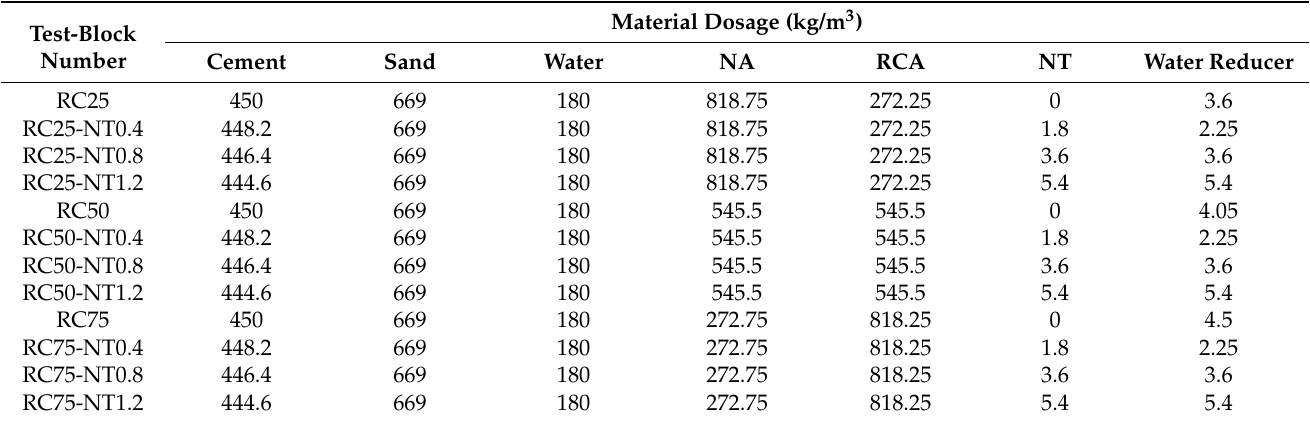
Table 6. Mix ratio of nano-TiO 2 recycle aggregate concrete (kg/m 3 ).